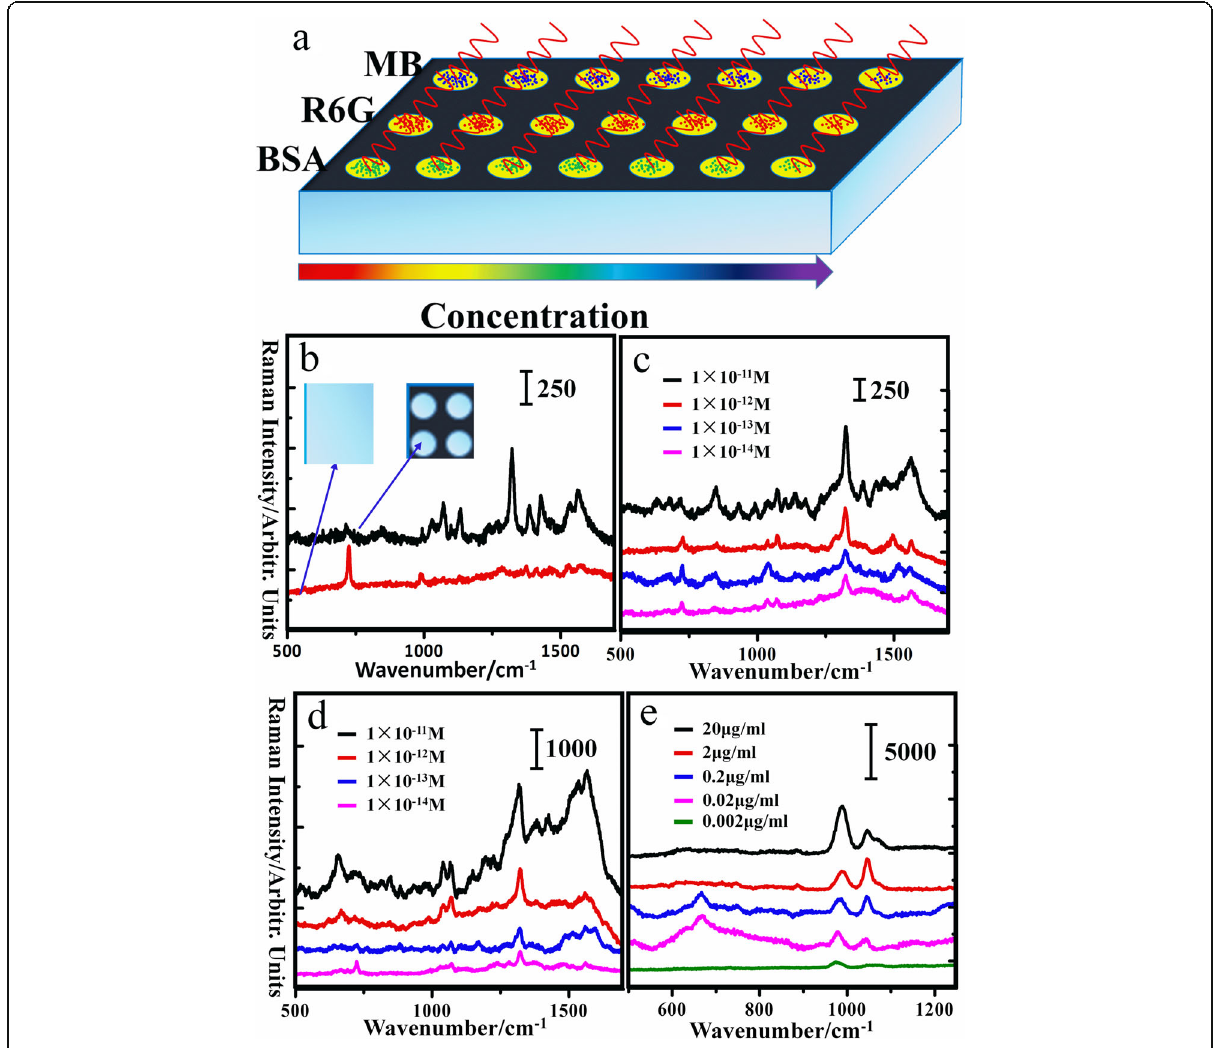
Fig. 5 a The diagrammatic sketch of detecting substance on the engraved PTFE. b SERS spectra of MB molecules with the same concentration (1 × 10 − 9 M) was obtained on original PTFE and engraved PTFE respectively. c , d , and e SERS spectra of MB molecules, R6G molecules, and BSA with various concentration